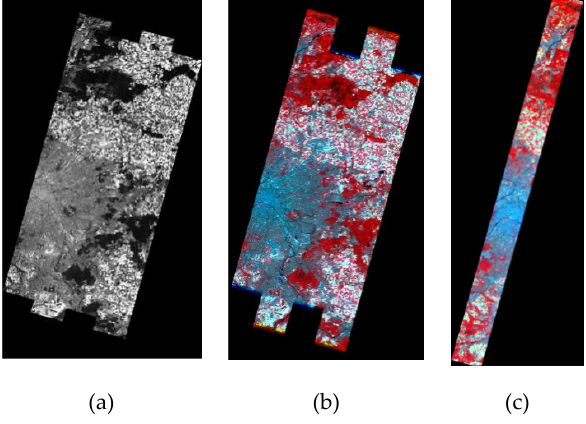
Figure 9. ALI PAN image ( a ), RGB compositions of ALI MSI ( b ) and Hyperion HSI over Paris ( c ).